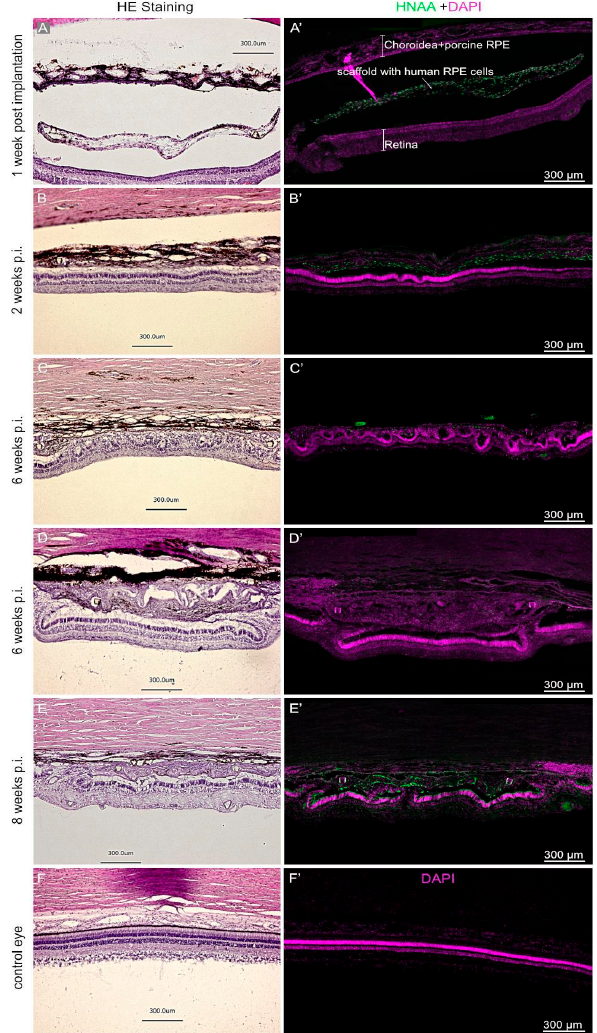
Figure 5. Hematoxylin & eosin staining of the retinal area containing the transplanted cells. Expres- sion of Human Nuclear Antigen (HNAA, green) was observed in hRPE cells at week 1 and 2 post implantation and only occasionally at 6 weeks. Observations are presented at 1 ( A , A’ ), 2 ( B , B’ ), 6 ( C , C’ , D , D’ ), and 8 ( E , E’ ) weeks as well as a control eye ( F , F’ ). Nuclear staining was performed by DAPI